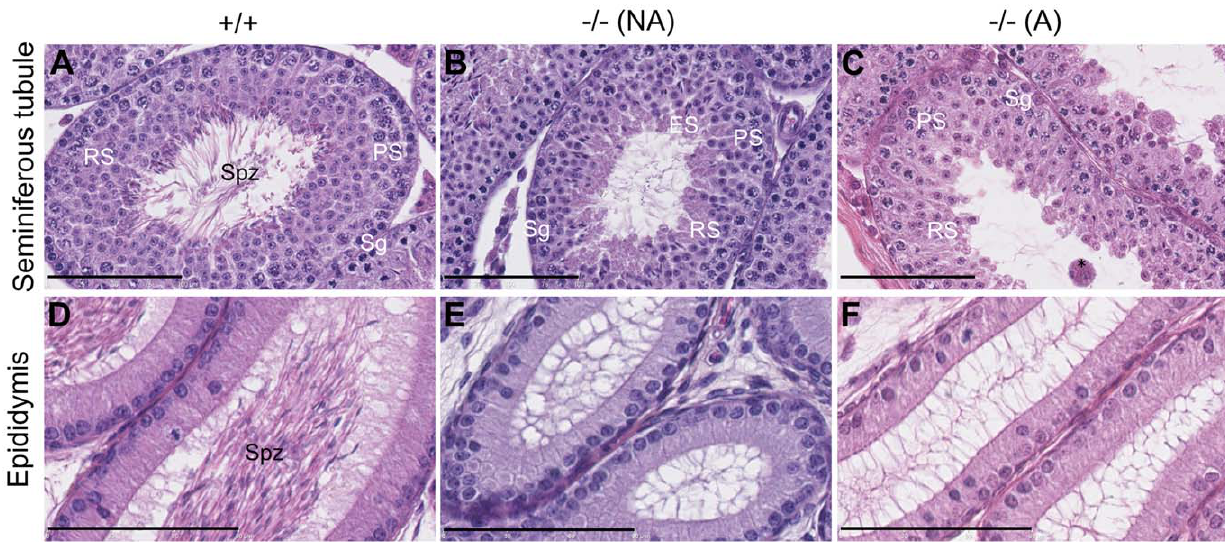
Figure 1. Incompletely penetrant blockage of spermiogenesis in Celf1 2 / 2 mice during the first wave of spermatogenesis. Representative histological sections of testes of + / + (left panels) and 2 / 2 (two right panels) mice at 42 days post-partum (dpp). A–C , seminiferous tubules. D–F , epididimes of the same respective mice. Depending on the presence of elongated spermatids in seminiferous tubules, KO mice were classified as ‘‘non affected’’ ( B , E ) or ‘‘affected’’ ( C , F ). Sg, Spermatogonia; PS, Pachytene Spermatocyte; RS, Round Spermatid; ES, Elongated Spermatid; Spz, Spermatozoa; *, multinuclear giant cell. Scale bars, 100 m m ( A–C ), 80 m m ( D–F ).